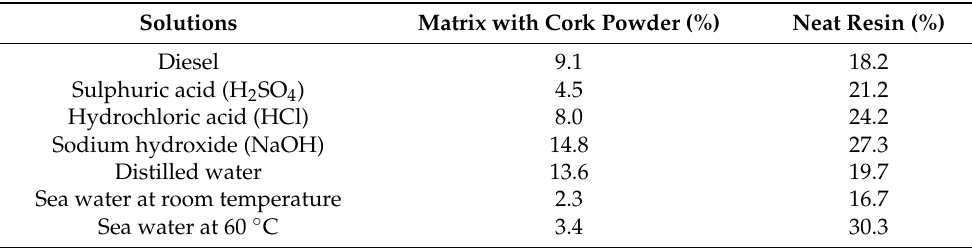
Table 6. Difference in the maximum displacement obtained for 30 days of immersion into different harsh solutions compared to non-immersed